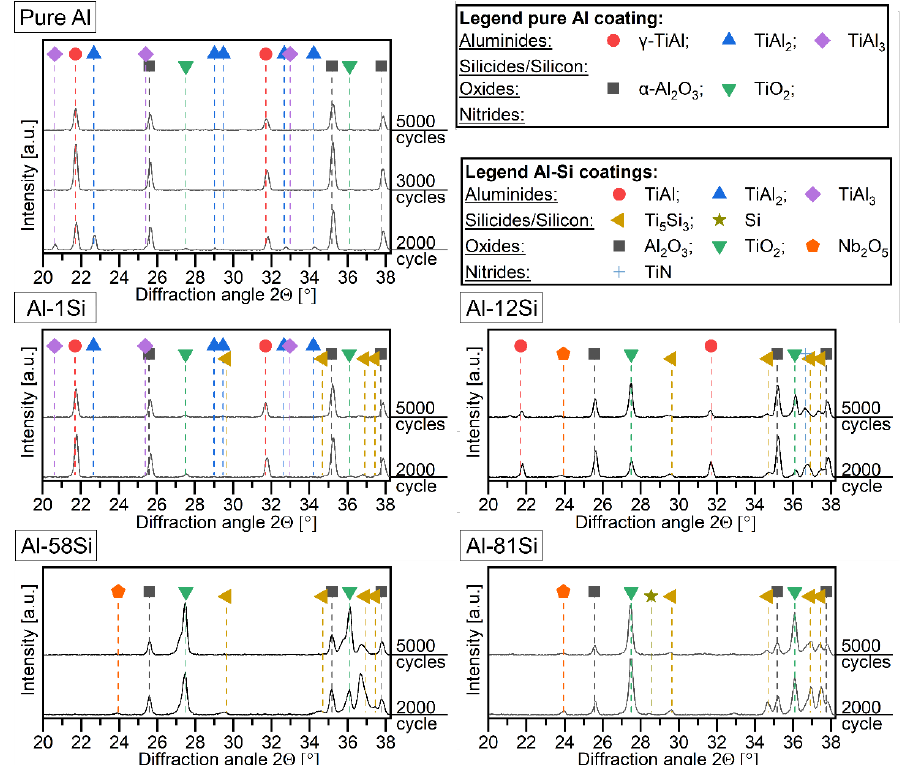
Figure 11. Representative XRD diffractograms of the pure Al and the Al-Si coatings (Al-1Si, Al-12Si, Al-58Si and Al-81Si in at.%) on the TNB-V2 substrate alloy after different amounts of 1 h cycles of exposure at 900 ◦ C in lab